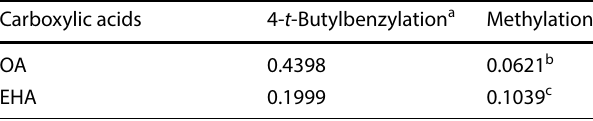
a Quantitative ions: m/z 275 b Quantitative ions: m/z